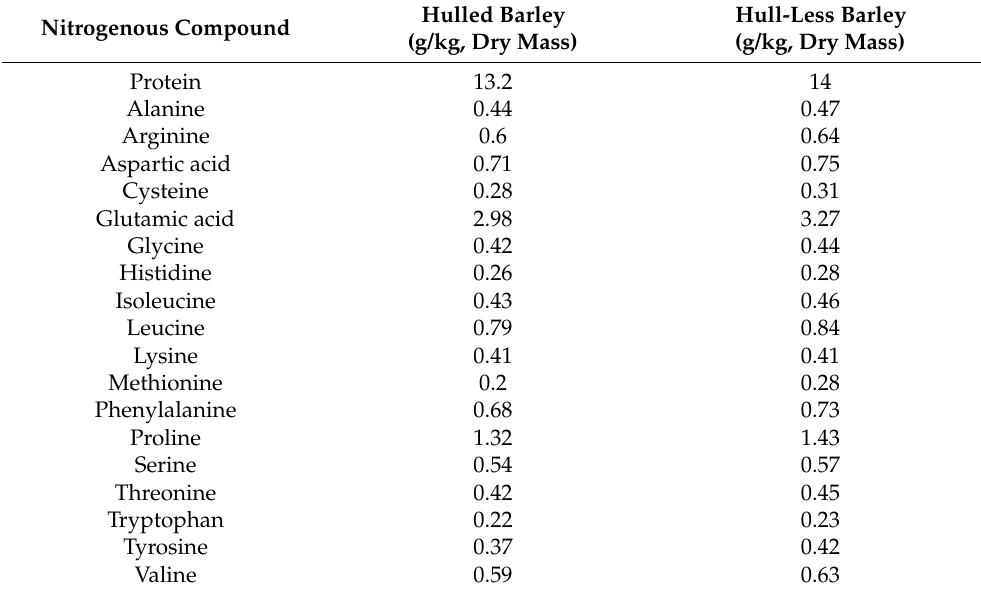
Table 2. The total amino acid content of hulled and hull-less barley, adapted from